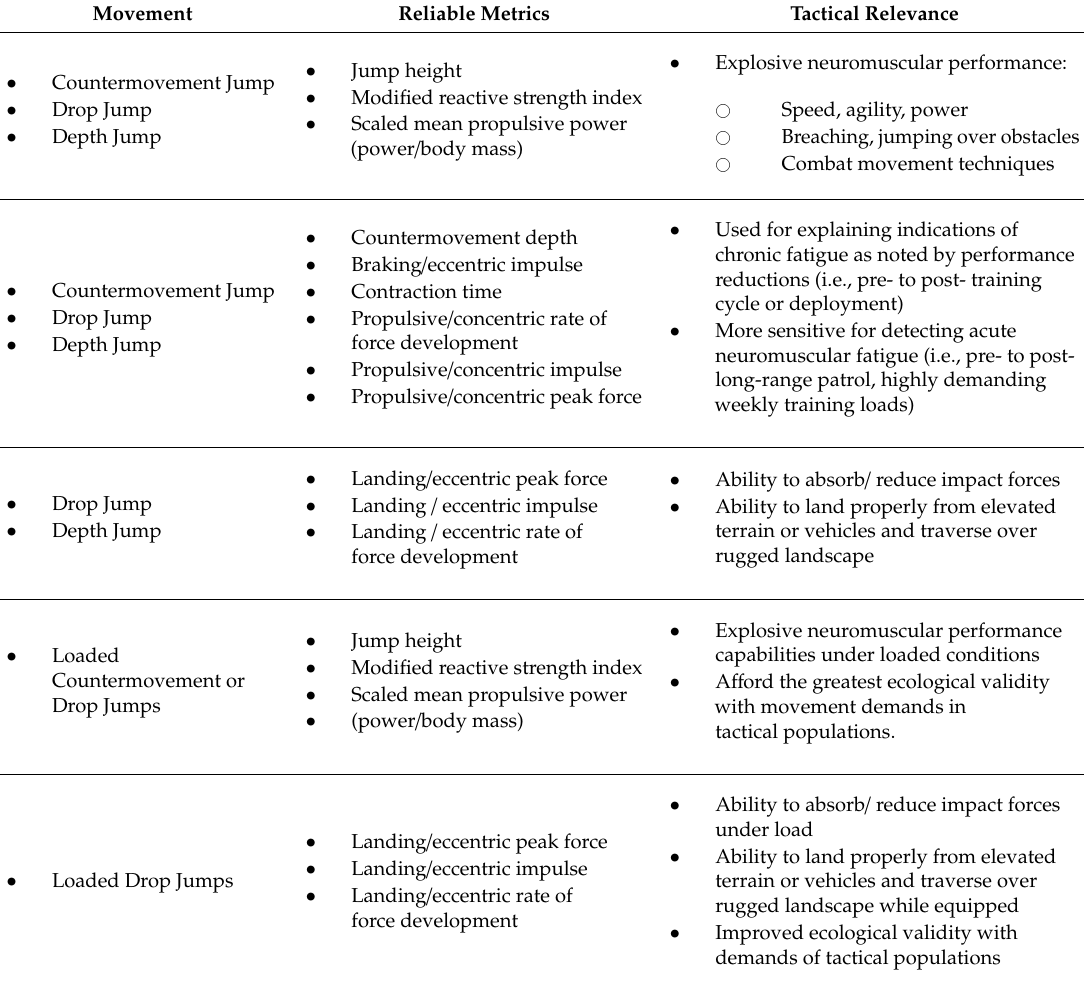
Table 3. List of Movements their associated Reliable Metrics, and Tactical